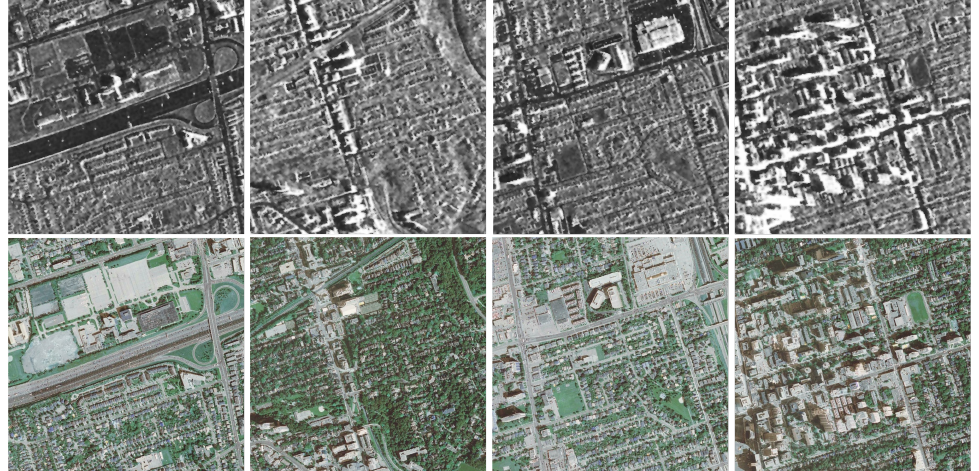
Figure 4. Sample pairs from dataset SAR2Opt. The ( top ) row depicts the SAR images from TerraSAR- X and the ( bottom ) row depicts the corresponding EO images from Google Earth